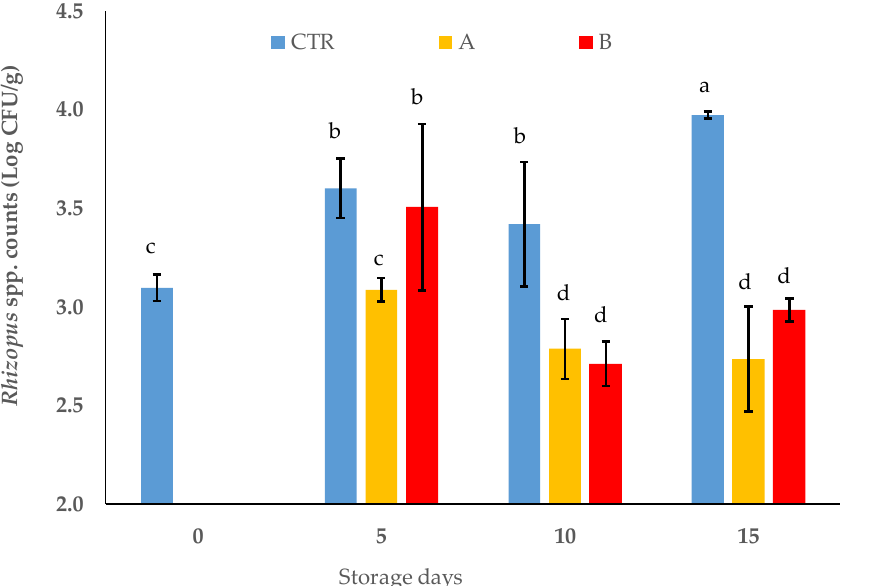
Figure 4. R . oryzae ITEM 18876 counts on the inoculated table grapes (cv. Italia) packed in HDPE bags with different citral doses (A equal to MIC value of 0.0125 µ L/cm 3 and B equal to 4-fold MIC value of 0.05 µ L/cm 3 , respectively) and stored at 12 ◦ C and 85% relative humidity for 15 days. CTR: control without citral. Bars are means ± standard deviations ( n = 9). Bars with different lowercase letters represent significantly different averages (p < 0.0001; HSD Tukey’s test; F (9.80) = 38.050, p = 2.549 × 10 − 25 ).